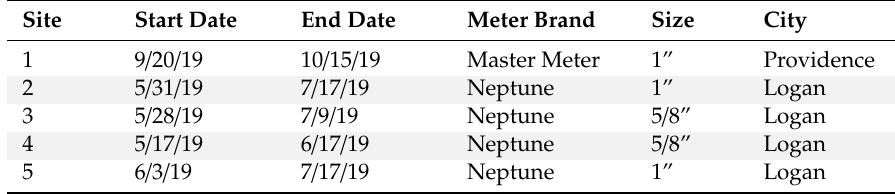
Table 8. Sites where a CIWS datalogger was installed, meter characteristics, and data collection